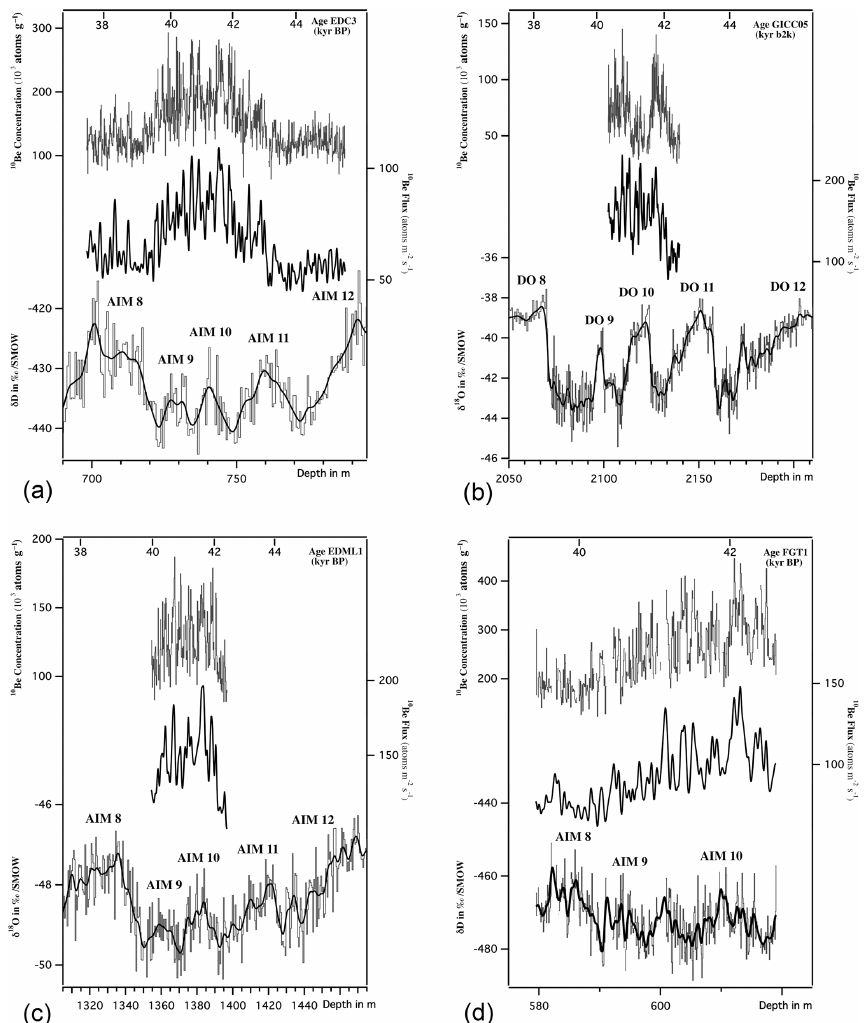
Figure 1. 10 Be concentrations, 10 Be flux and stable isotope profiles ( δ D or δ 18 O) and their running averages as a function of depth and age in four ice cores: (a) EPICA Dome C, EDC3 timescale (Parrenin et al., 2007); (b) NGRIP, GICC05 timescale (Andersen et al., 2006); (c) EDML, EDML1 timescale (Ruth et al., 2007); and (d) Vostok, FGT1 timescale (Parrenin et al., 2004). The 10 Be flux has been calculated using accumulation rates used in the above timescales and smoothed with a 50-year binomial filter. AIM stands for Antarctic isotope